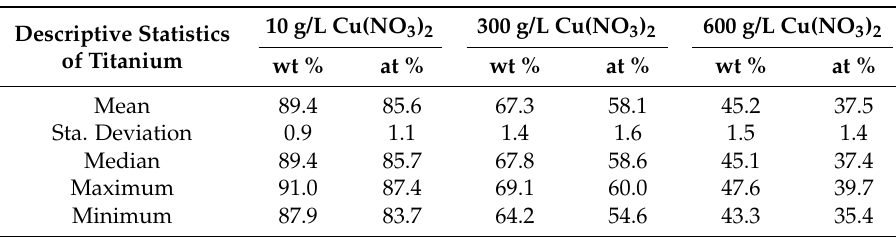
Table 3. Descriptive statistics of the amount of titanium in the surface layer formed on titanium after PEO.